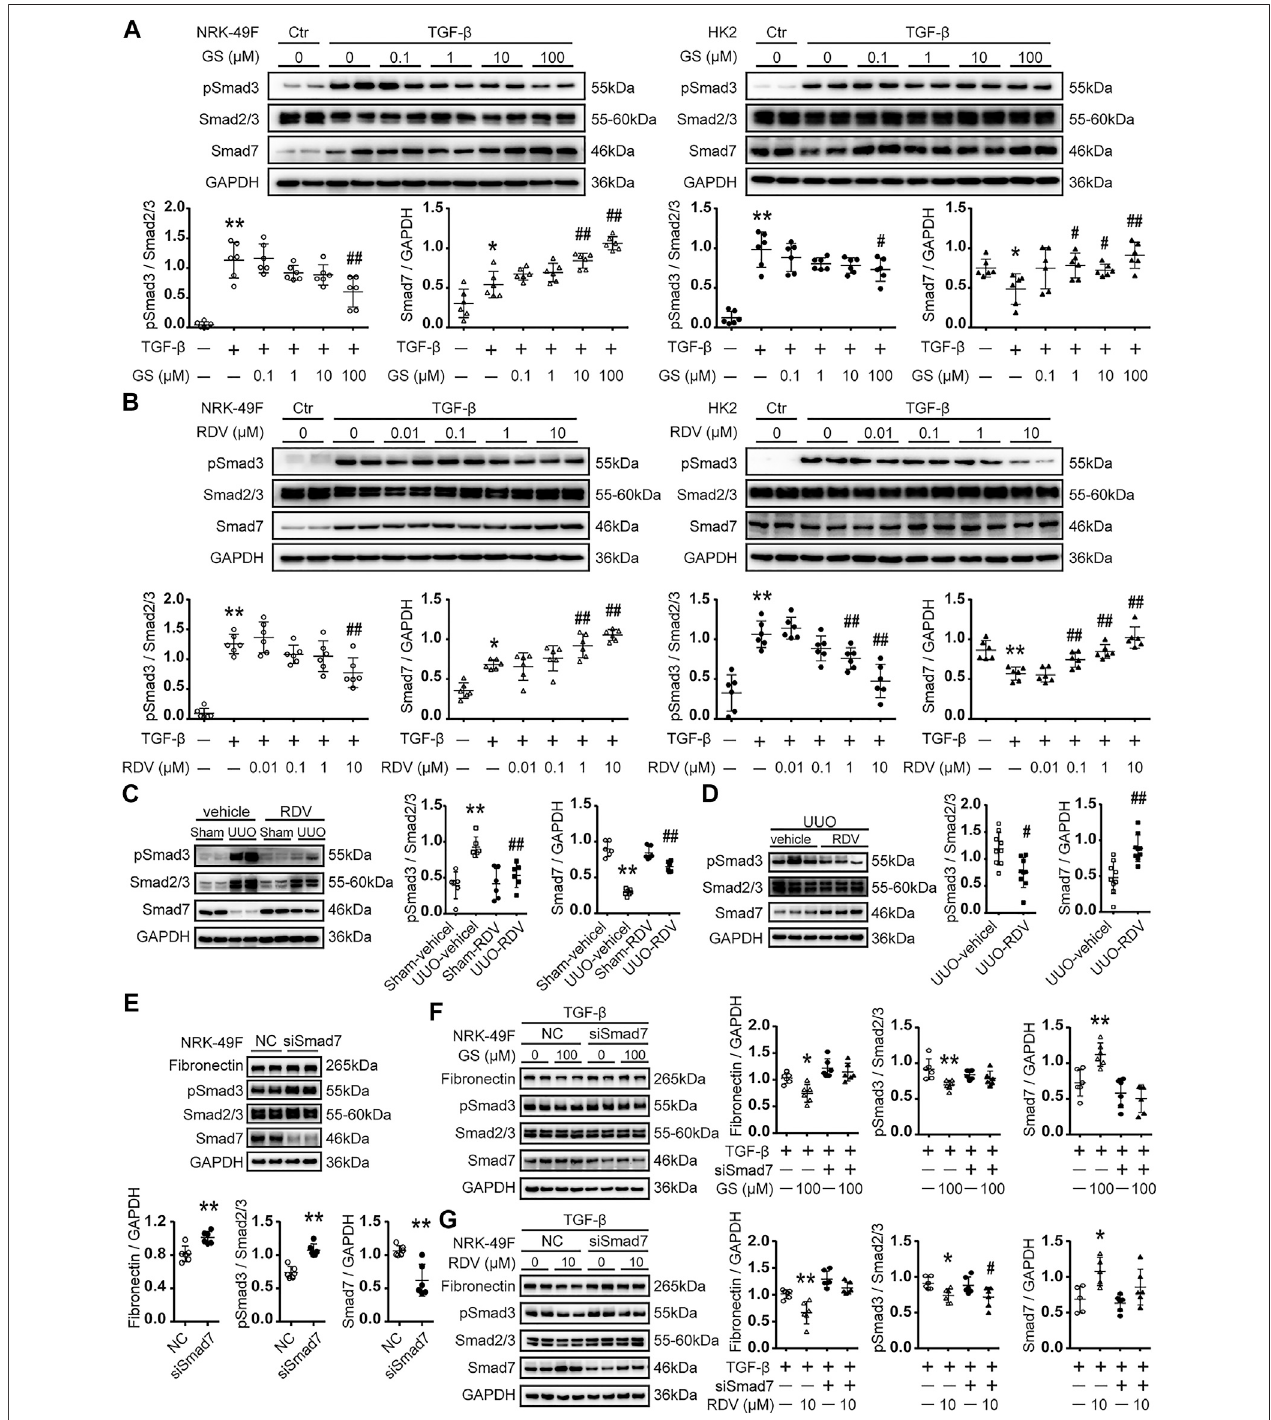
FIGURE 4 | The expression of Smad7 and phosphorylation of Smad3 was regulated by RDV in vitro and in vivo (A) Following TGF- β stimulation, NRK-49F cells or HK2 were treated with various concentration of GS for 24 or 48 h, respectively. The expression of Smad7 and phosphorylated Smad3 (pSmad3) were analyzed by Westernblotting and quanti fi ed (B) TGF- β stimulated NRK-49F or HK2 cells were treated with various concentration ofRDV for 24 or 48 h, respectively. The expression of Smad7 and pSmad3 were analyzed by Western blotting and quanti fi ed. Data represent mean ± SD. ** p < 0.01 vs. Vehicle-DMSO; # p < 0.05 vs. TGF- β -DMSO; ## p < 0.01 vs. TGF- β -DMSO. One representative result of at least three independent experiments is shown (C) After sham or UUO operation, wide type c57 mice were treatedwith10 mg/kg/dRDVbyi.p.injectionfor10 days.TheexpressionofSmad7andpSmad3wasmeasuredbyWesternblotting.Onerepresentativeofatleastthree